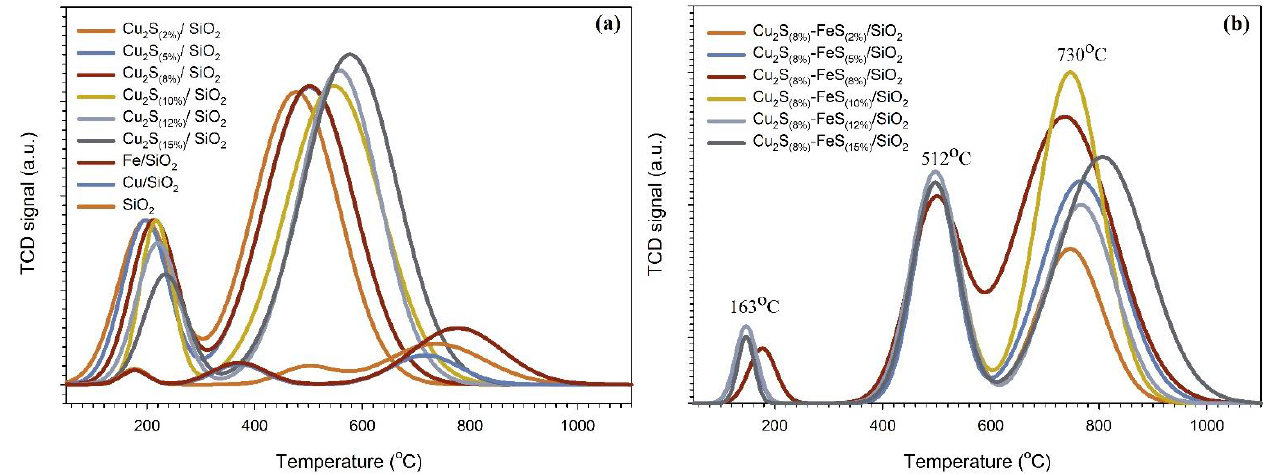
Figure 3. TPD-NH 3 analysis of the prepared catalysts. ( a ) TPD-NH 3 profile for SiO 2 and monometallic catalyst; ( b ) TPD-NH 3 of bimetallic CuS-FeS/SiO 2 ) catalysts. Analysis conditions are 0.05 g of catalyst, analysis range of 50 °C to 950 °C, and holding time of 30 min at 950 °C.